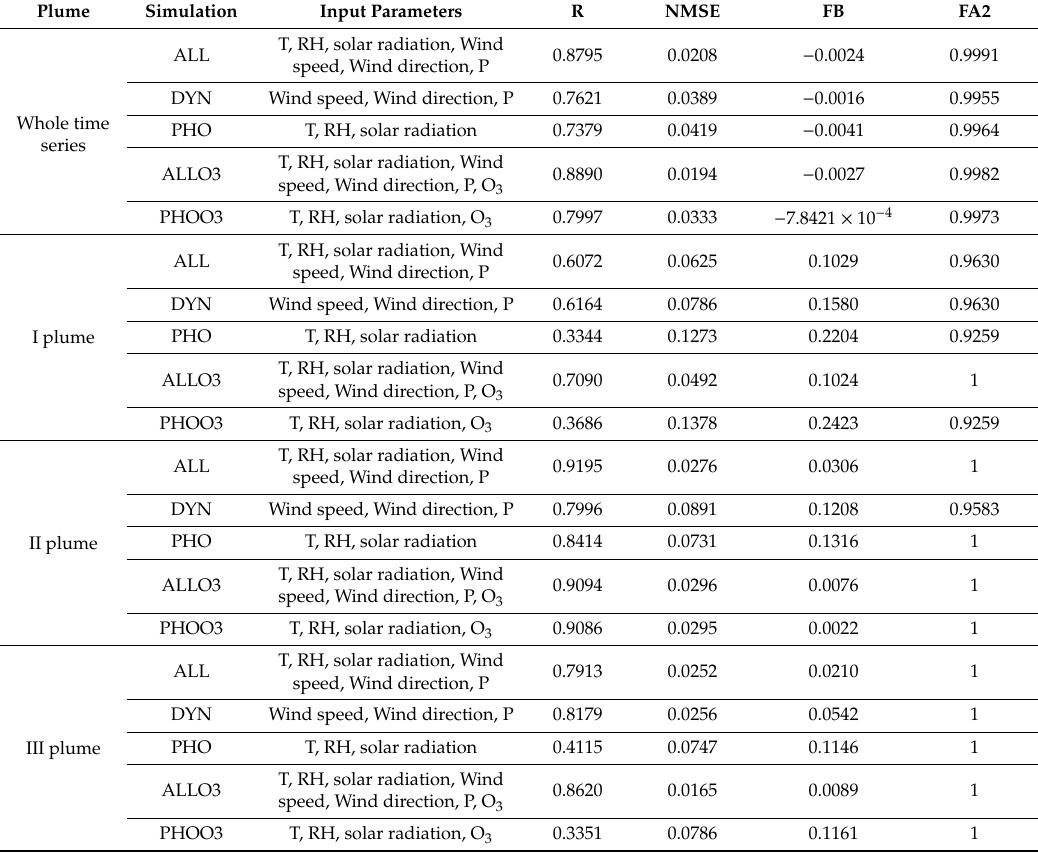
Table 1. Summary of the performance of the FFNs in the NO modeling for di ff erent input node simulations. R is the correlation coe ffi cient, NMSE is the normalized mean square error, FB the fractional bias, and FA2 the factor of two. T: temperature; RH: relative humidity; P: